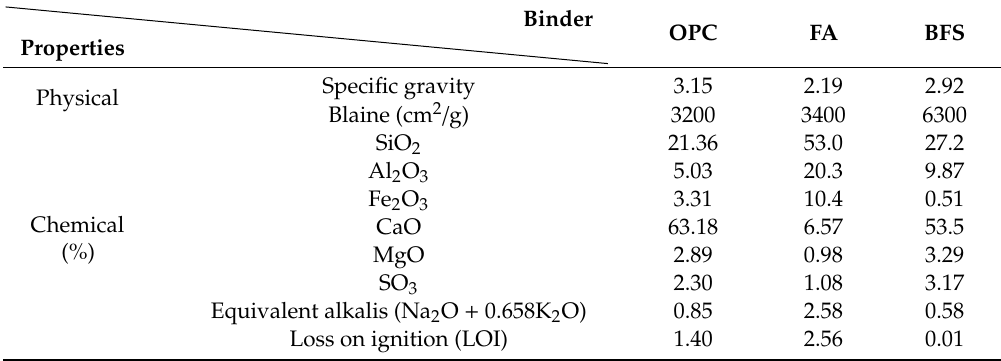
Table 1. Physical properties and chemical compositions of the binders.